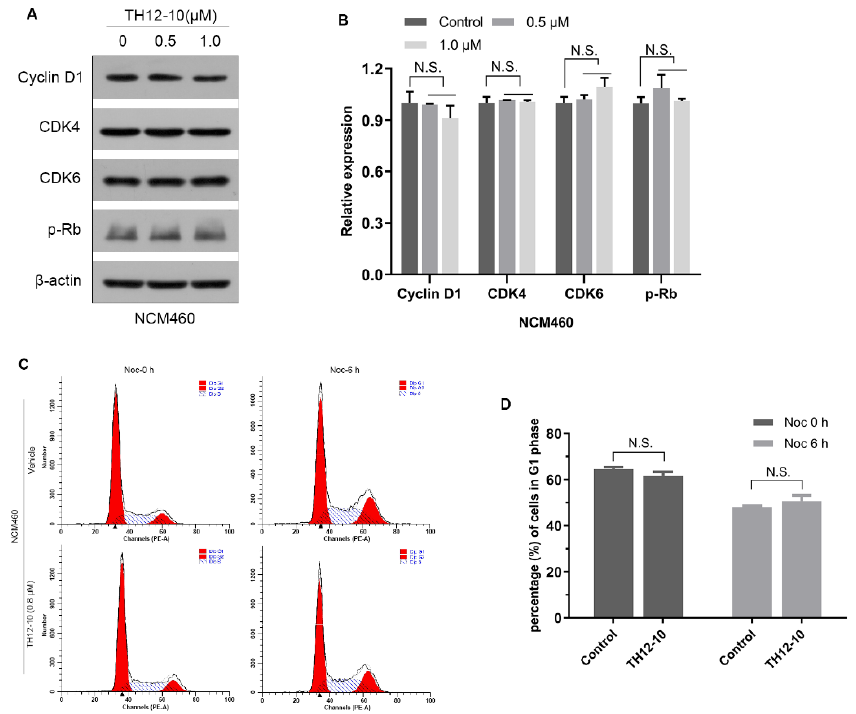
Figure 4. The contribution of TH12-10 to the cell cycle. ( A ) Western blotting shows Cyclin D1, CDK4, CDK6, and p-Rb levels in NCM460 cells treated with TH12-10 at indicated concentrations for 48 h. ( B ) Densitometry analysis of indicated proteins as described in ( A ) was conducted and presented. ( C ) Flow cytometric analysis for cell-cycle distribution in NCM460 cells treated with TH12-10 or vehicle and then with nocodazole for a total of 48 h. ( D ) Quantitative analysis of NCM460 cells in G1 phase as described in ( C ). All data are presented as means ± SD of three independent experiments. N.S., not significant. Differences were tested using one-way ANOVA ( B ) or the unpaired t-test with Welch’s correction ( D